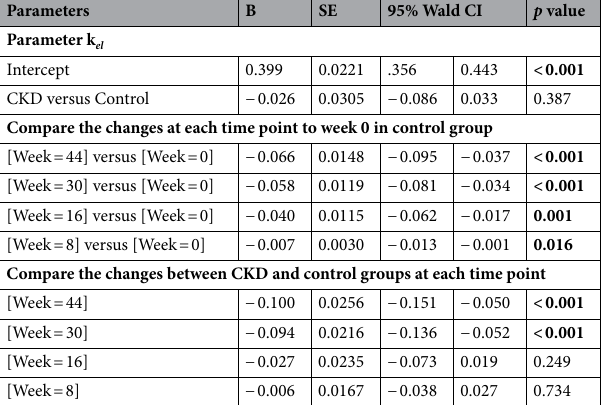
Table 4. Comparisons of perfusion parameter k el between control and CKD groups over 44 weeks by GEE multiple linear regression. B: regression coefficient.